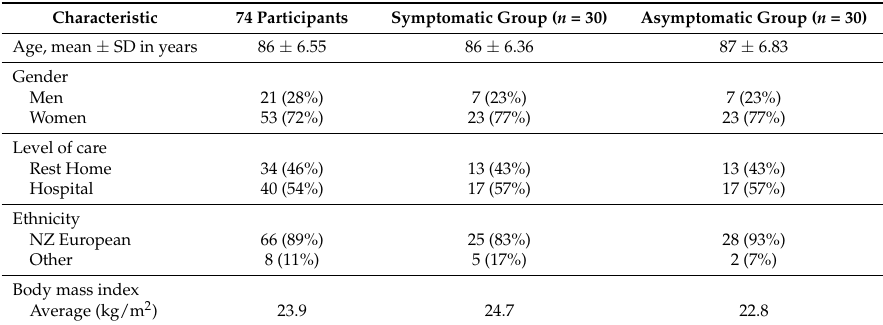
Table 1. Baseline demographic of 74 participants who completed GSRS-IBS questionnaire and 30 participants each selected for symptomatic and asymptomatic groups.